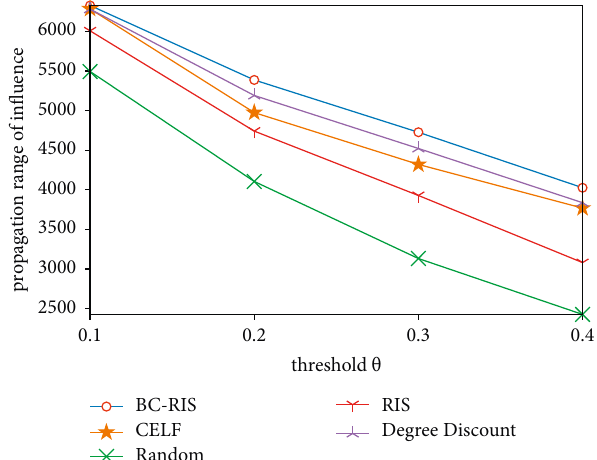
Figure 5: Positive influence propagation range of different in- fluence maximization algorithms, and number of seed nodes is